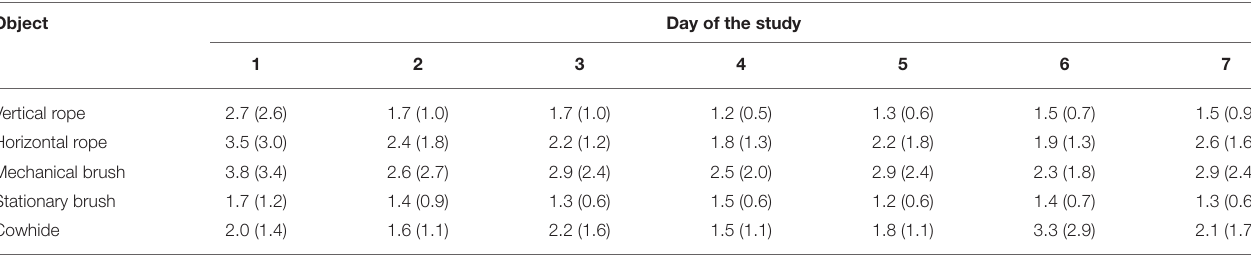
TABLE 2 | Average (mean ± SD) number of visits to the enrichment objects per day of the study, for using five enrichment objects observed in 25 calves kept in groups of five for five replicates recorded continuously 12h per day, for 1 week, based on raw data. Object